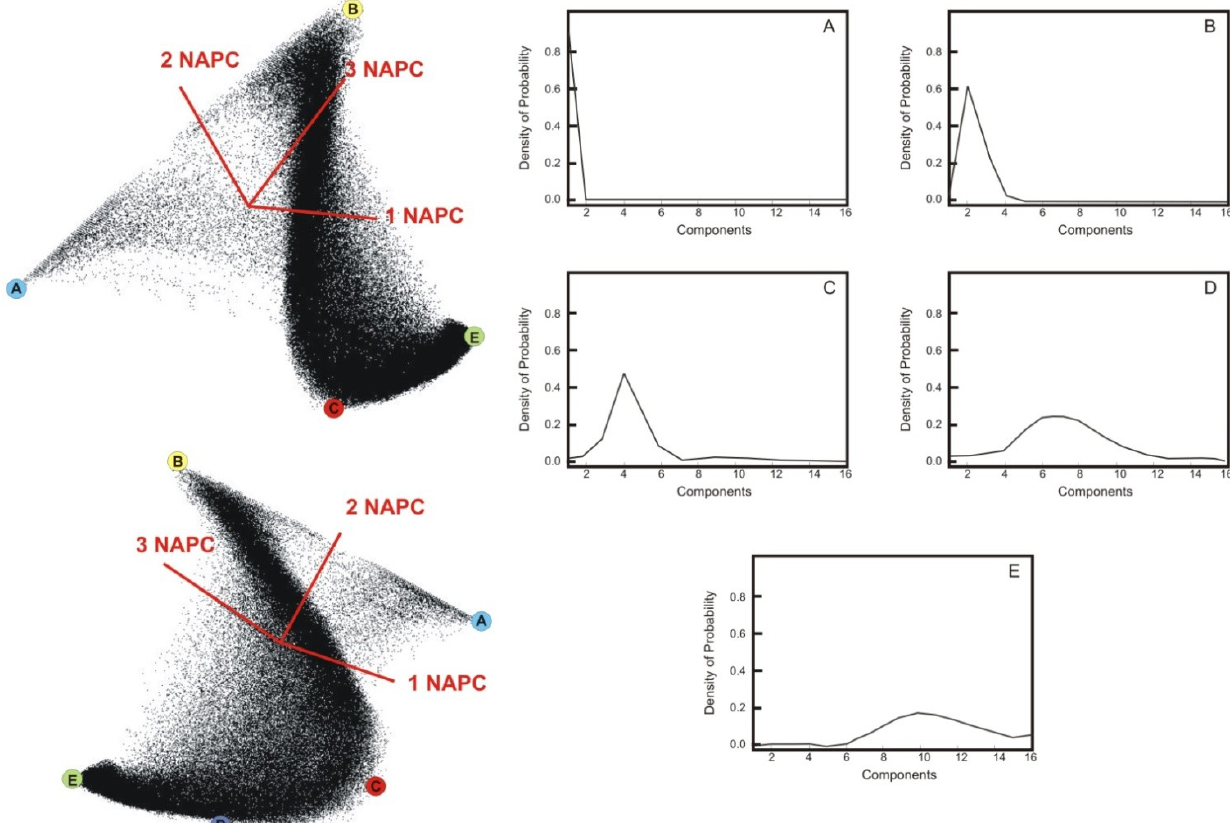
Figure 10. Endmember identification using the n-dimensional scatter